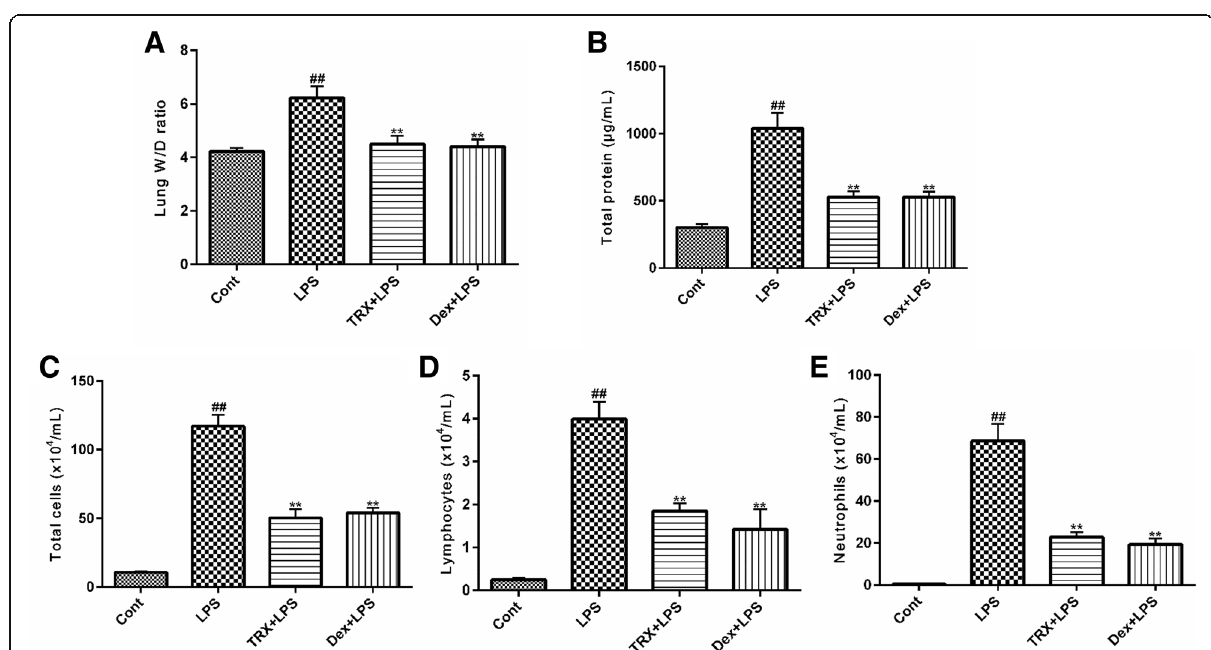
Fig. 5 The lung W/D ratio ( a ), total protein concentration ( b ), the number of total cells ( c ), lymphocytes ( d ) and neutrophils ( e ) in the BALF was determined 24 h after LPS challenge. Data presented are the mean ± SEM ( n = 6 – 8). ## P < 0.01 compared with control group, ** P < 0.01 compared with LPS group (one-way ANOVA)